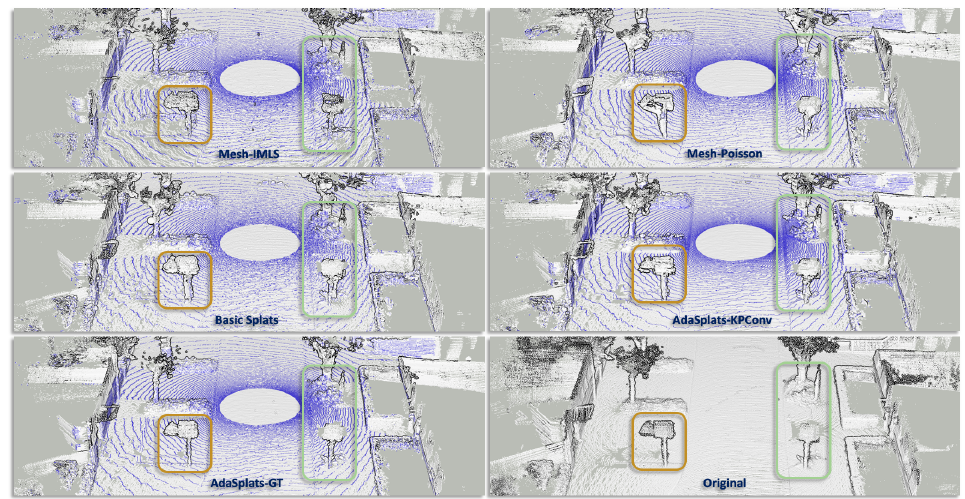
Figure 11. Comparison of simulated LiDAR data using different reconstruction and modeling methods on SemanticKITTI. The top row shows the simulation in meshed IMLS ( left ) and Poisson ( right ). The middle row shows the simulation with Basic Splats ( left ) and AdaSplats-KPConv ( right ). The bottom row shows the simulation with AdaSplats-GT ( left ) and original point cloud ( right ). Table 5. Results on SemanticKITTI. We report the time taken (Gen T) in seconds to generate the primitives (triangular mesh or splats), the number of generated primitives (Gen Prim) in millions (M), rendering frequency in Hz (Render Freq) with a resolution of 2560 × 1440 pixels, LiDAR simulation frequency (LiDAR Freq) of the Velodyne HDL-64, and cloud-to-cloud (C2C) distance between the simulated and original point